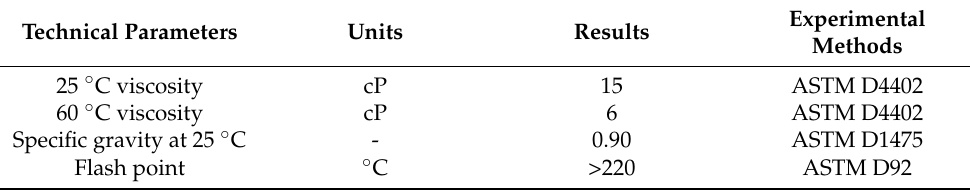
Table 1. Technical parameters of BRA.